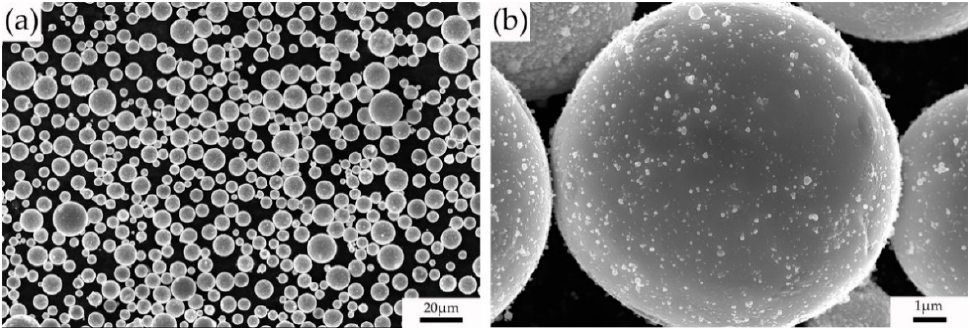
Figure 3. Morphology of the 90W ‐ 7Ni ‐ 3Fe powder. ( a ) Low magnification; ( b ) high magnification.